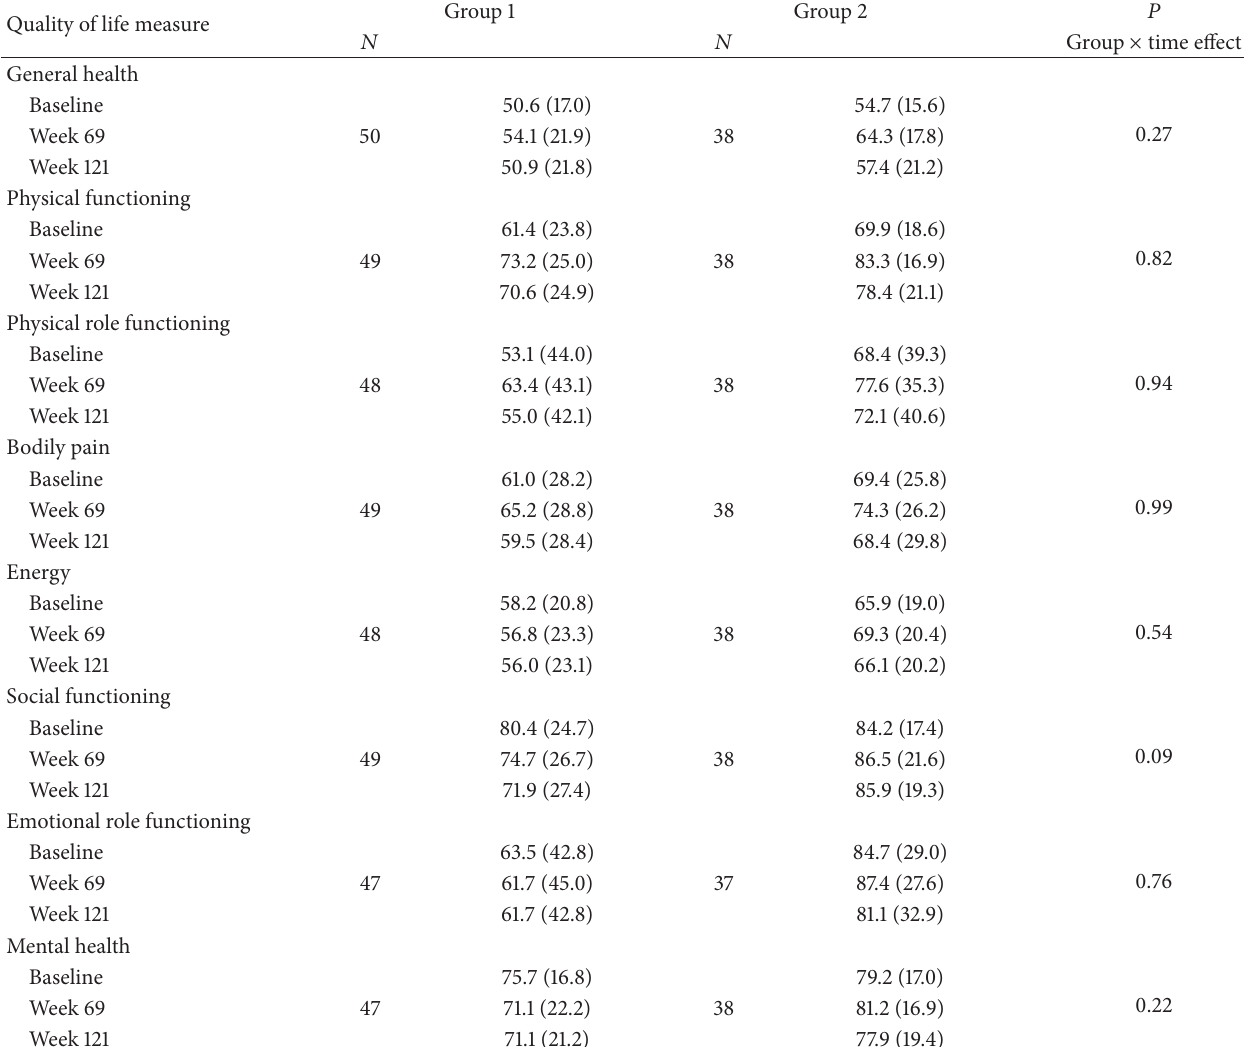
Table 4: Mean quality of life scores (SD) in Group 1 (17-week program) and Group 2 (17-week program with one-year maintenance) during the